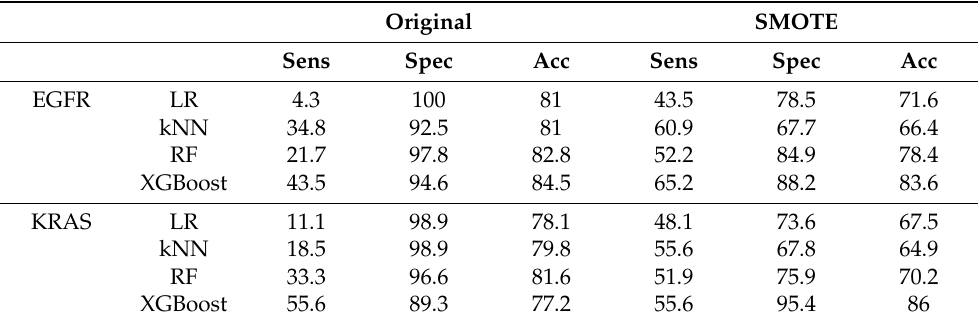
Table 2. Assessment of different feature selection-based machine learning models for predicting EGFR and KRAS